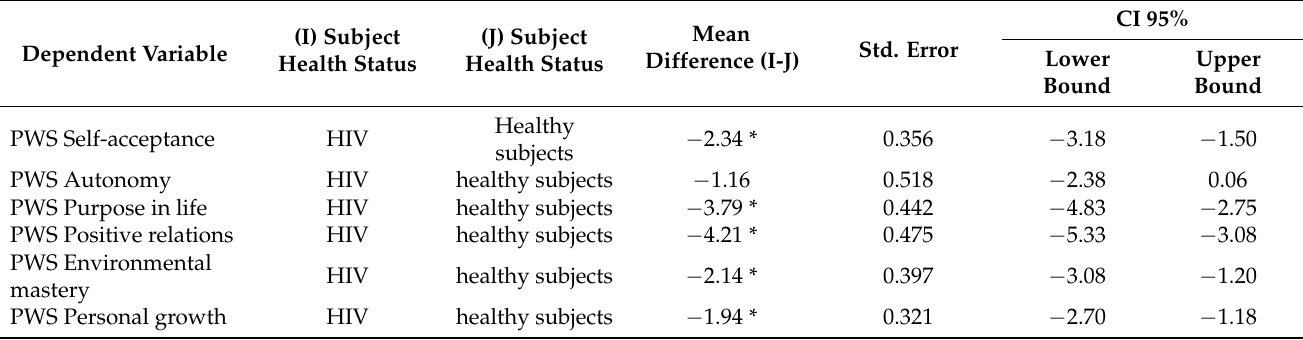
Table 8. Multiple comparisons: dimensions of psychological